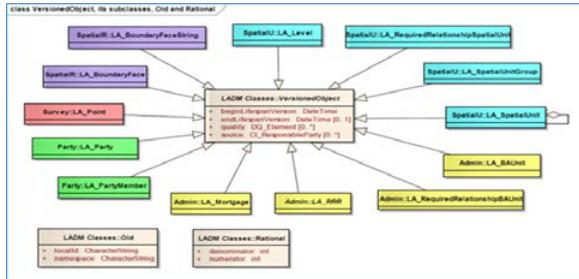
Figure 2: The representation of spatial temporal elements using LADM (Leksono et al. 2011; Babalola et al.